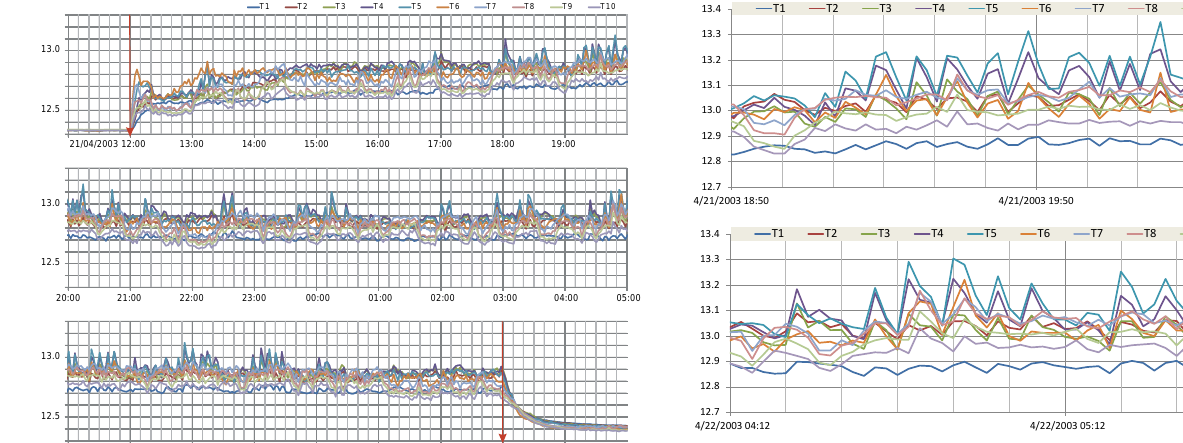
Figure 9. The temperatures during the A6a experiment heating in the periods 21 April 2003 at 18:50–20:40 (upper panel) and 22 April 2003 at 04:12–05:52 (lower panel): temperature is given in ◦ C. T1– T10 denote temperature series of the 10 sensors on the AIII setup.